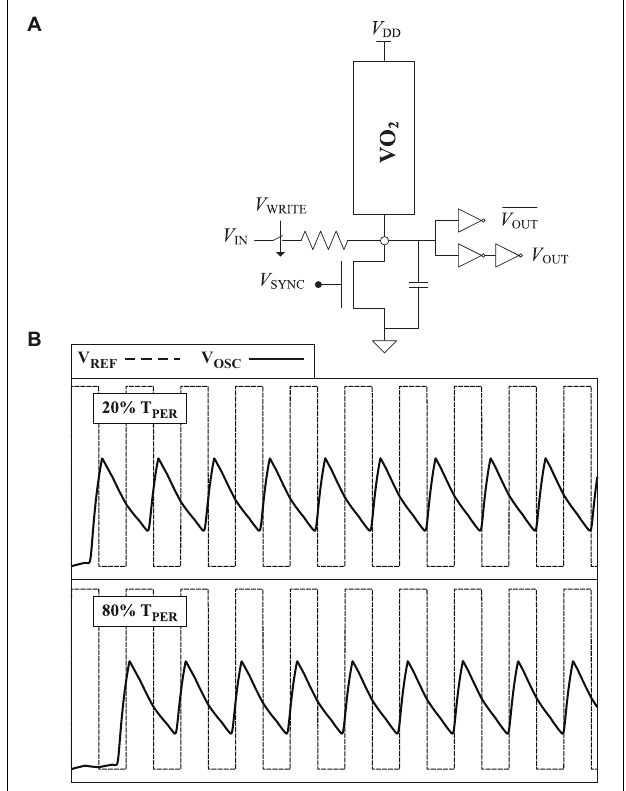
FIGURE 4 | Proposed neuron. (A) Schematic. (B) Operation for two values of the delay of the supply voltage.